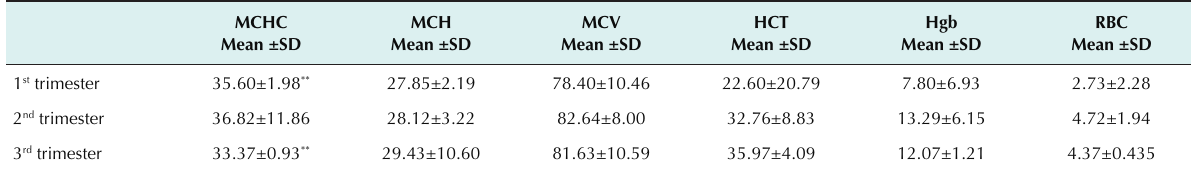
Table 6. Erythrogram in the 1 st , 2 nd , and 3 rd Trimesters in Preeclampsia